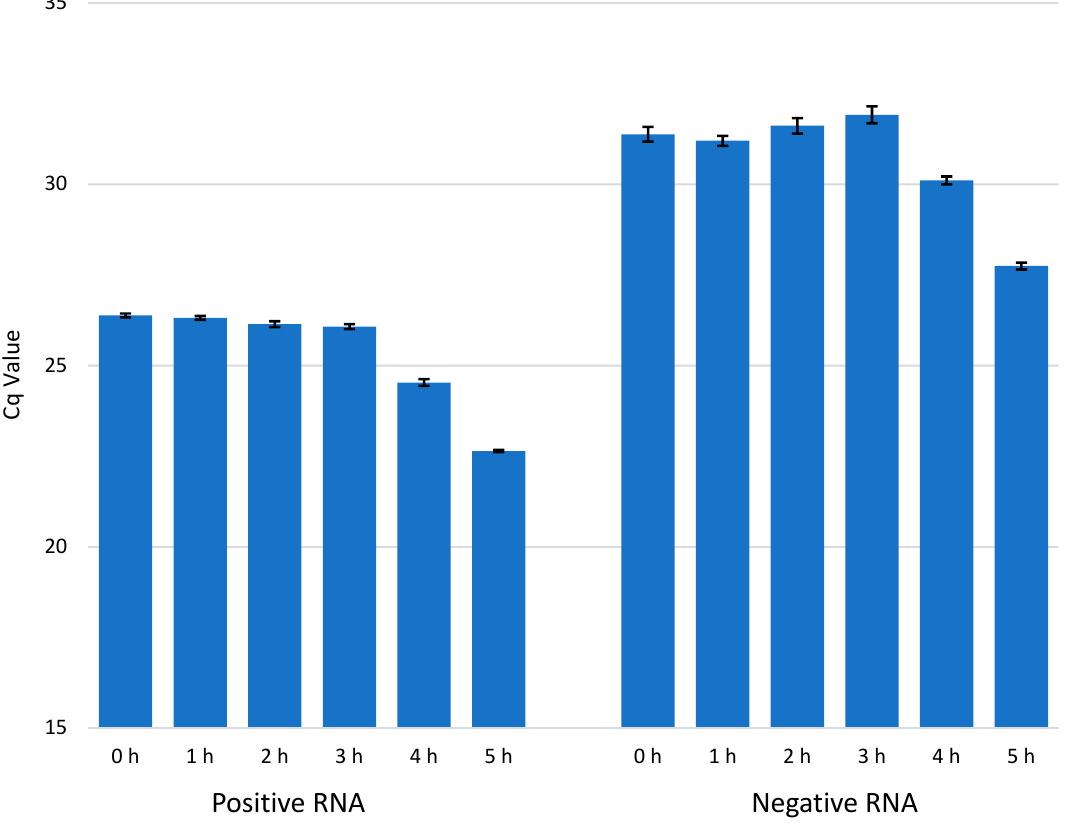
Figure 4. The amount of viral + RNA and − RNA in CVA9-infected cells at timepoints 0–5 h p.i. The amount of + RNA at timepoints 0–5 h p.i. is shown on the left, and the amount of − RNA at timepoints 0–5 h p.i. is shown on the right. The bars are averages calculated from triplicate samples, and the error bars are standard deviations from the average values.